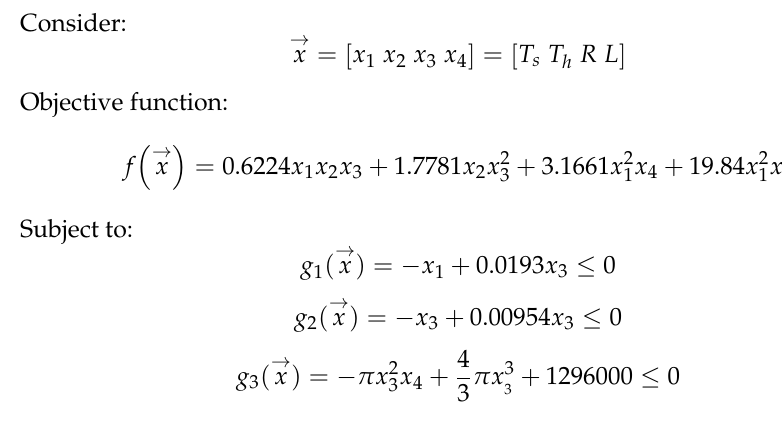
Figure 8. Model of pressure vessel design.